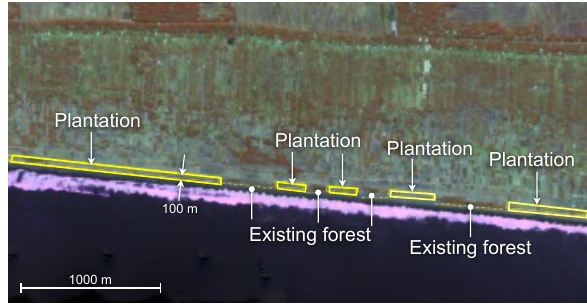
Fig.5. Example of the planned plantation layout on the coastline Fig. 5. Example of the planned plantation layout on the coastline.